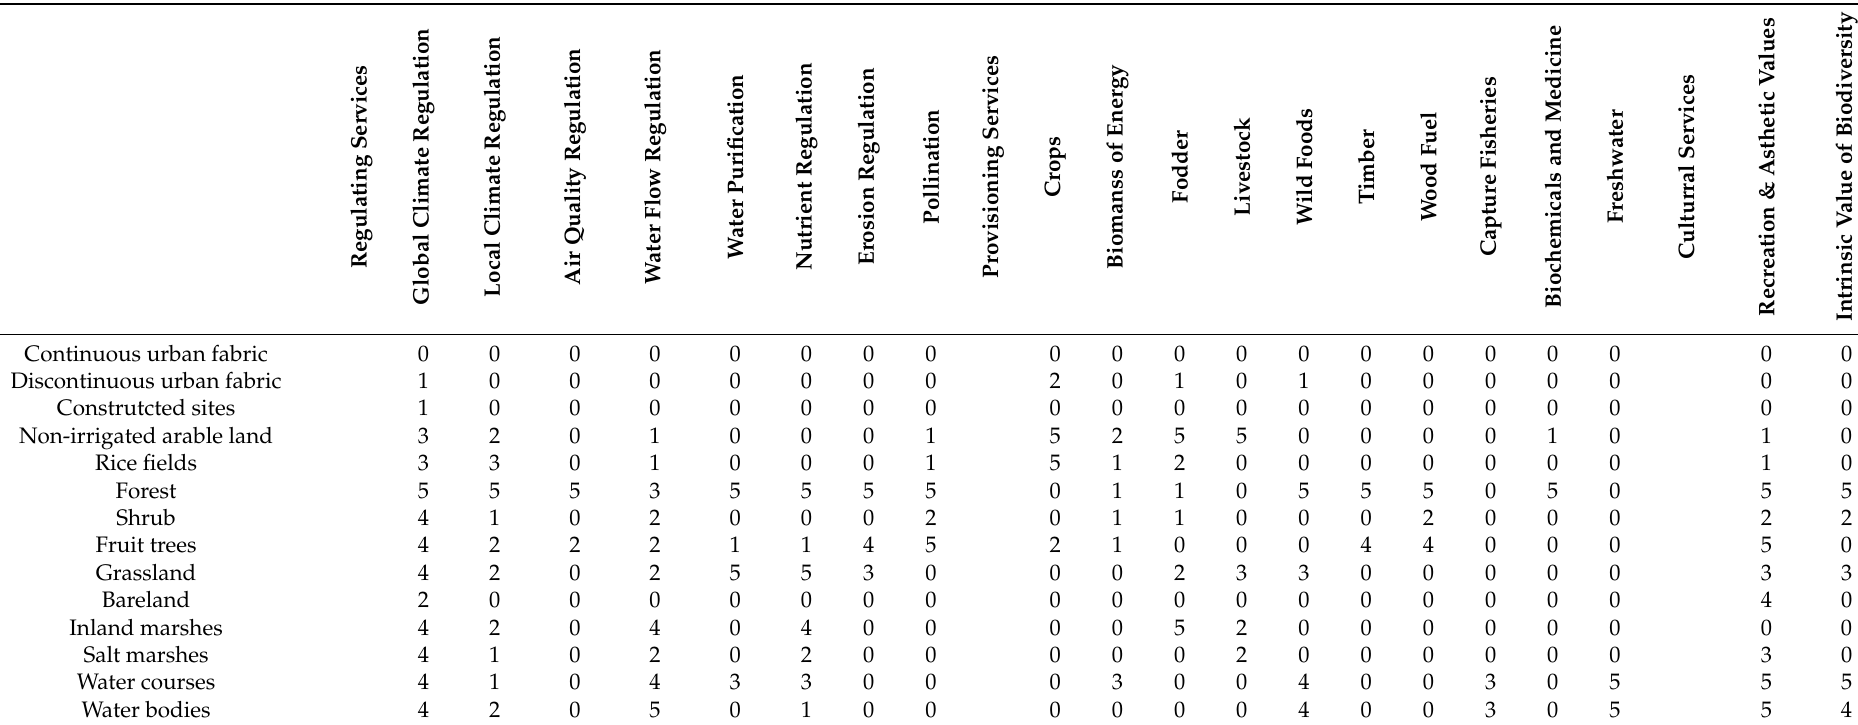
Table 1. Matrix illustrating capacities of different land cover classes to supply